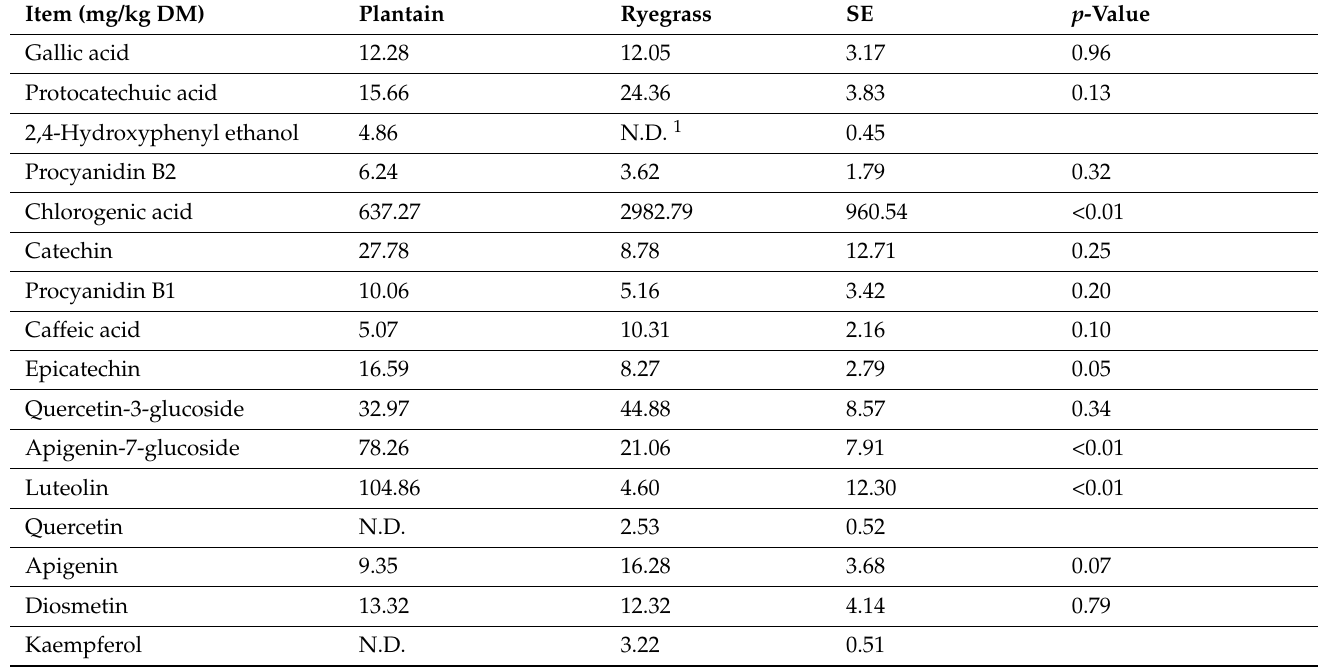
Table 2. Herbage phenolic compound content of feed provided to cows considered divergent for milk urea nitrogen breeding values (MUNBV) consuming a diet of either plantain or ryegrass.